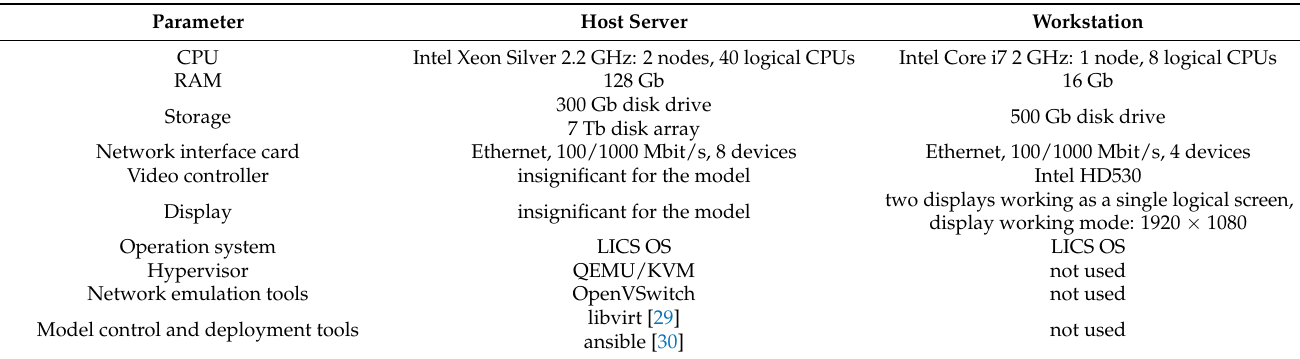
Table 4. Real computer parameters.